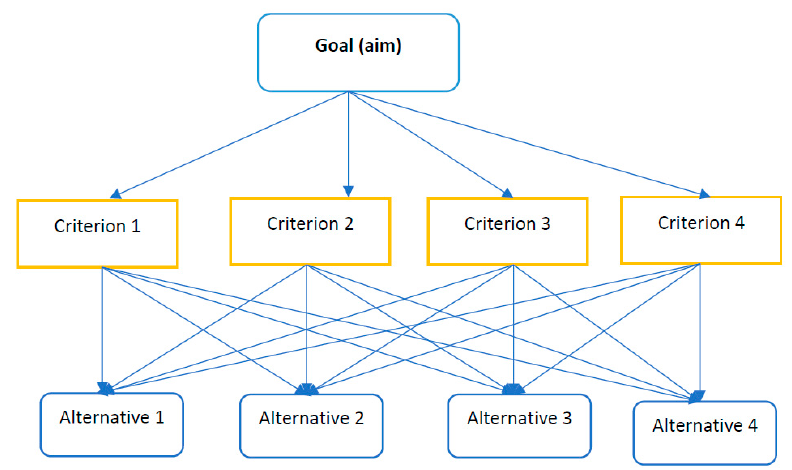
Figure 2. Schematic representation of three phase of AHP comparison pathway.